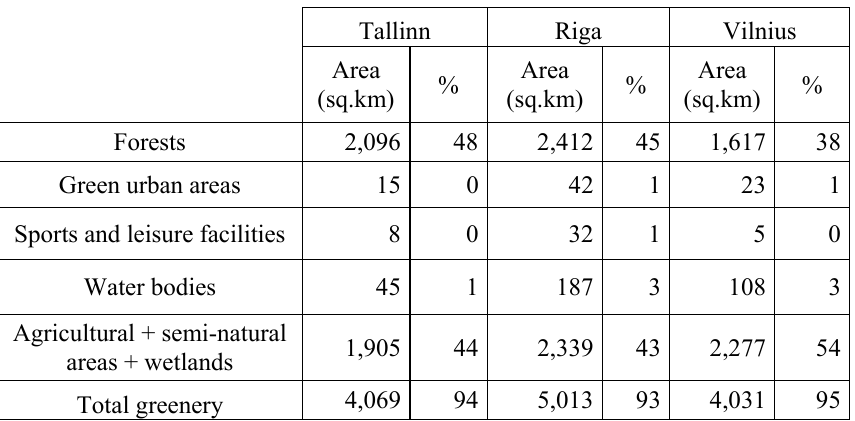
Table 2. Greenery in the FUAs of the Baltic States by CORINE classes (2006 data) (beaches, bare rocks, sparsely vegetated and burnt areas excluded) (data source: EEA)